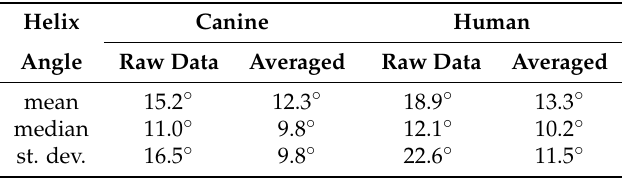
Table 2. Statistics of the error in the helix angle.